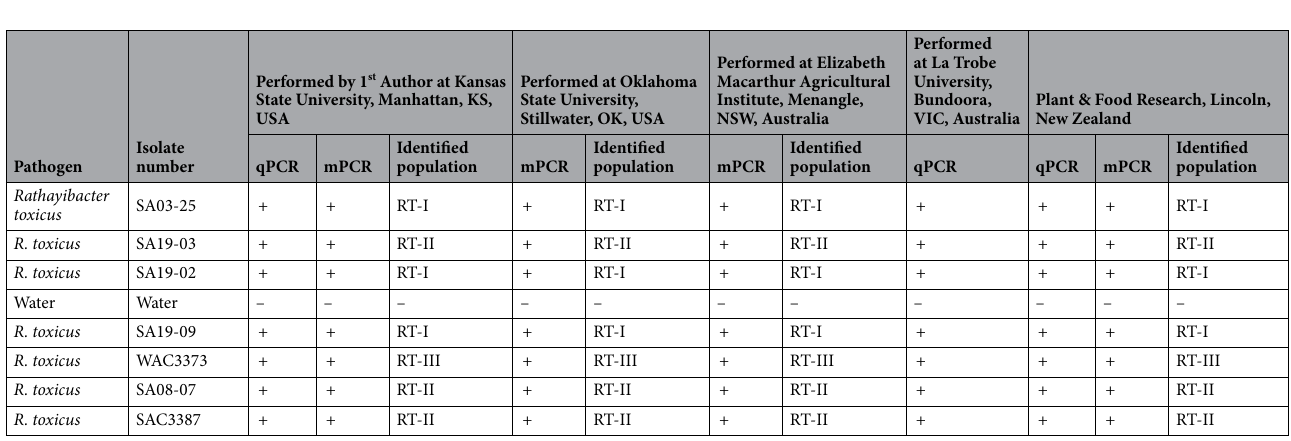
Table 4. Blind test results of the Rathayibacter toxicus specific assays performed by multiple operators in multiple national and international labs. These assays were performed with internal control at different time intervals; assays at Oklahoma State University, La Trobe University, Elizabeth Macarthur Agricultural Institute and Plant & Food Research on 12/2014, 11/2015, 12/2015 and 12/2015, respectively. The assays were repeated twice by 1 st author as well. mPCR is multiplex PCR; qPCR is quantitative TaqMan PCR.